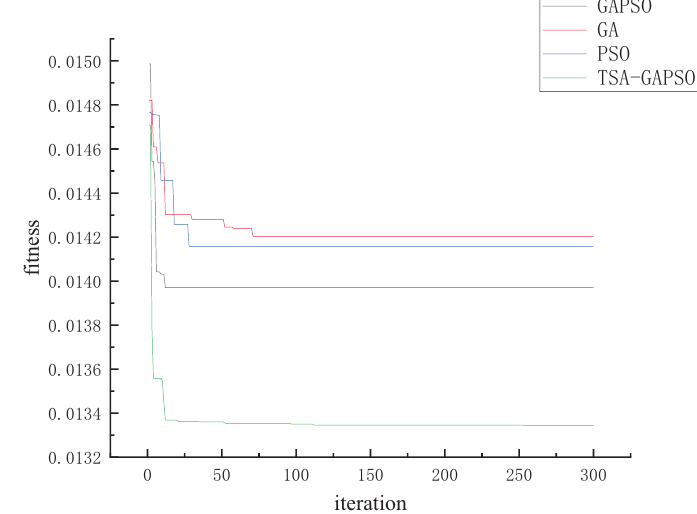
Figure 5. Comparison diagram of algorithm